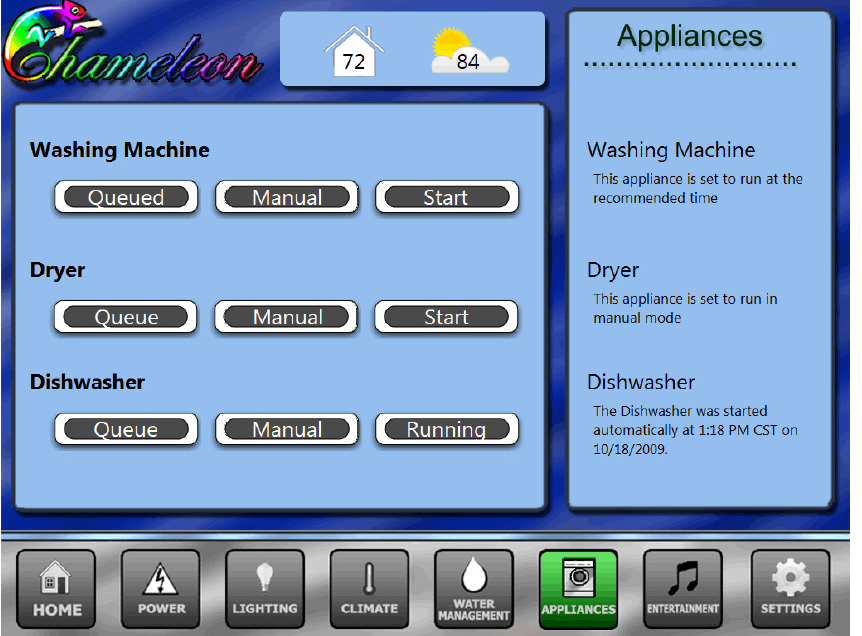
Figure 3. Appliance tab from in-home Human Machine